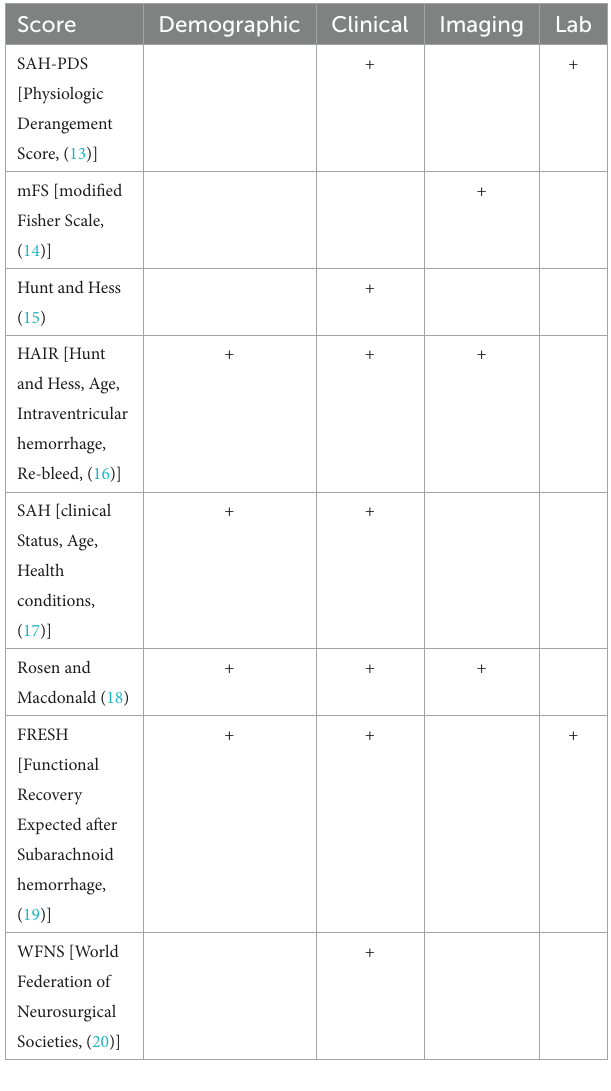
TABLE 1 Overview of prognostic scores and included